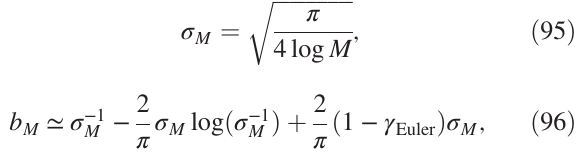
Fig. 15. The scaling factor and shift are